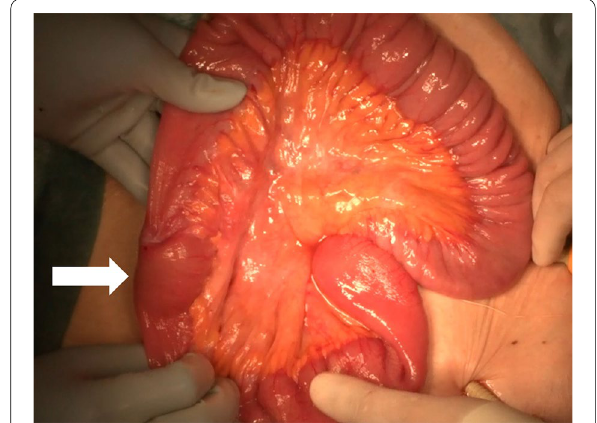
Fig. 2 Intraoperative findings. A mass, approximately 4 cm in diameter, as a leading point for intestinal intussusception is detected